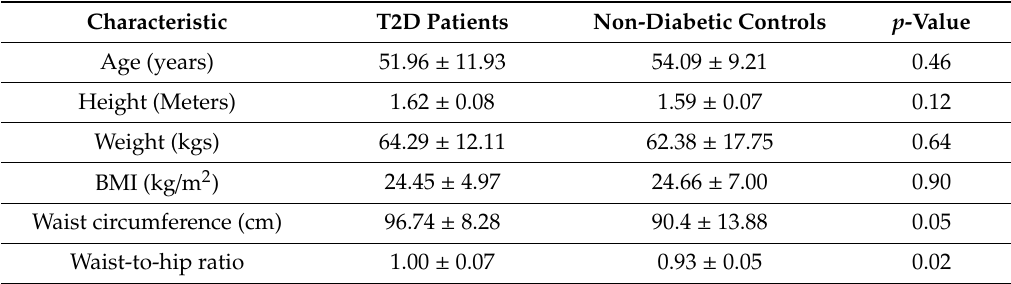
Table 2. Baseline characteristics of the T2D patients and non-diabetic controls.